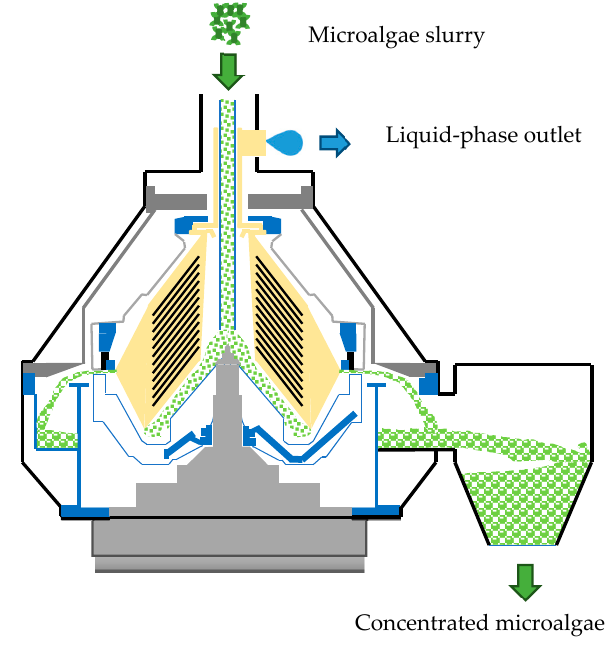
Figure 3. Disk-stack centrifuge used at the Minamisoma pilot